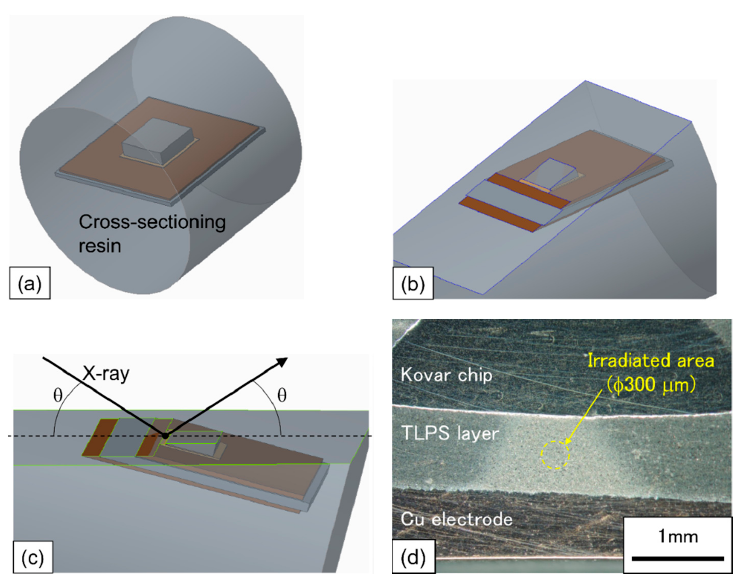
Figure 3. XRD method using tilted cross-sectioning: ( a ) before cross-sectioning, ( b ) after cross-sectioning, ( c ) schematic of XRD arrangement, and ( d ) irradiated area of the transient liquid-phase sintered (TLPS) layer.